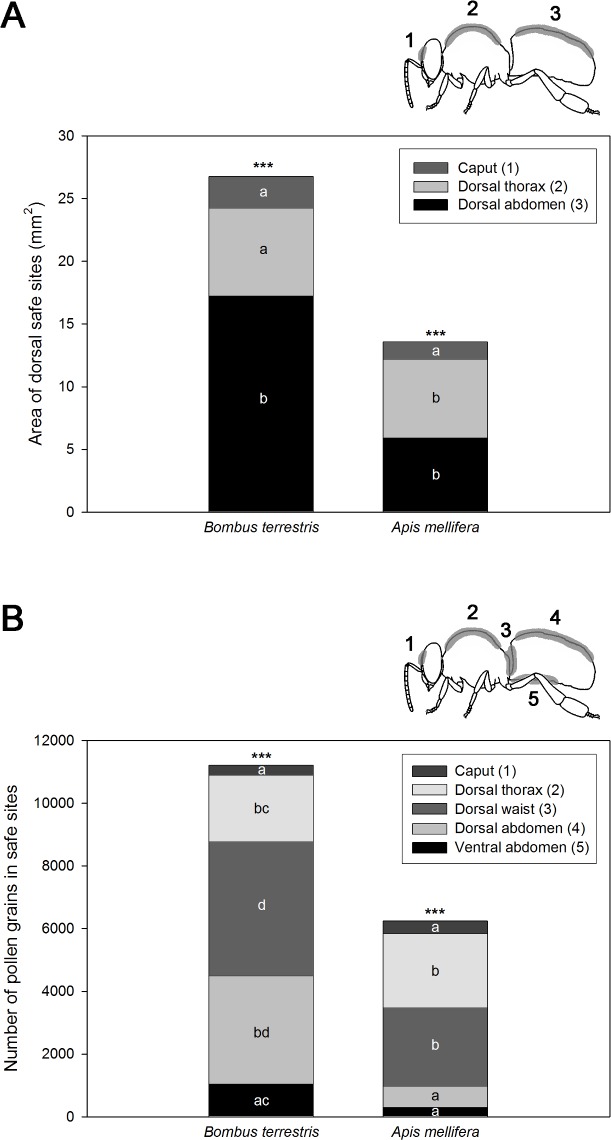
Dorsal safe site areas (A) and amount of pollen grains in safe sites (B) of Bombus terrestris and Apis mellifera. Mean values that share same letters per bee species are not significantly different according to Tukey post-hoc tests at p < 0.05 following ANOVA (*** indicates p < 0.0001). Safe site area (A): B. terrestris: caput n = 19, thorax n = 32, abdomen n = 17, A. mellifera: caput n = 14, thorax n = 20, abdomen n = 8. Pollen amount in safe sites (B): B. terresris: n = 12, A. mellifera: n = 12.